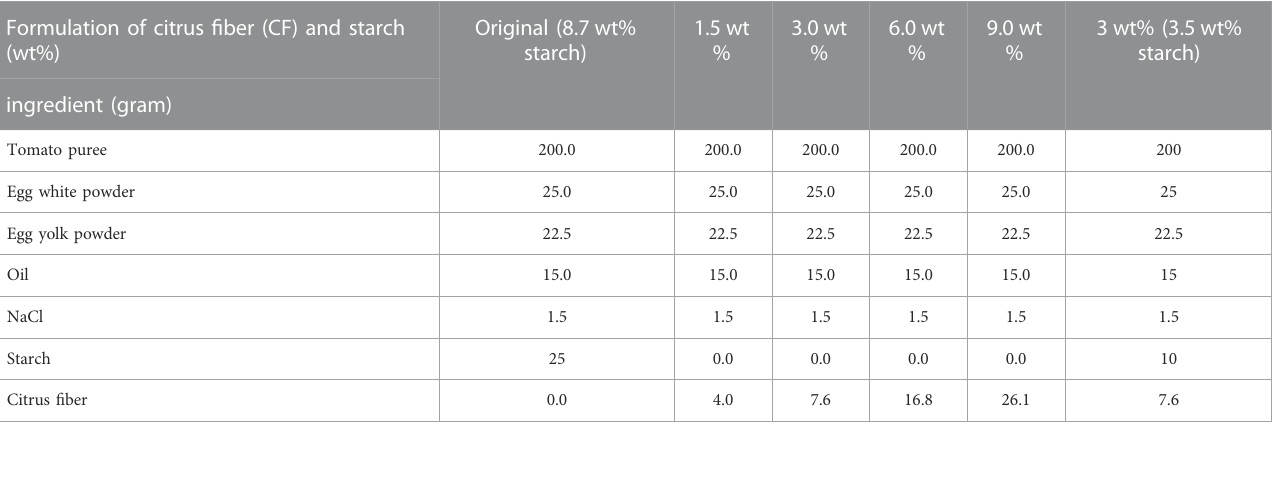
TABLE 2 Comparison of parameters in the fl ow sweep. Sample